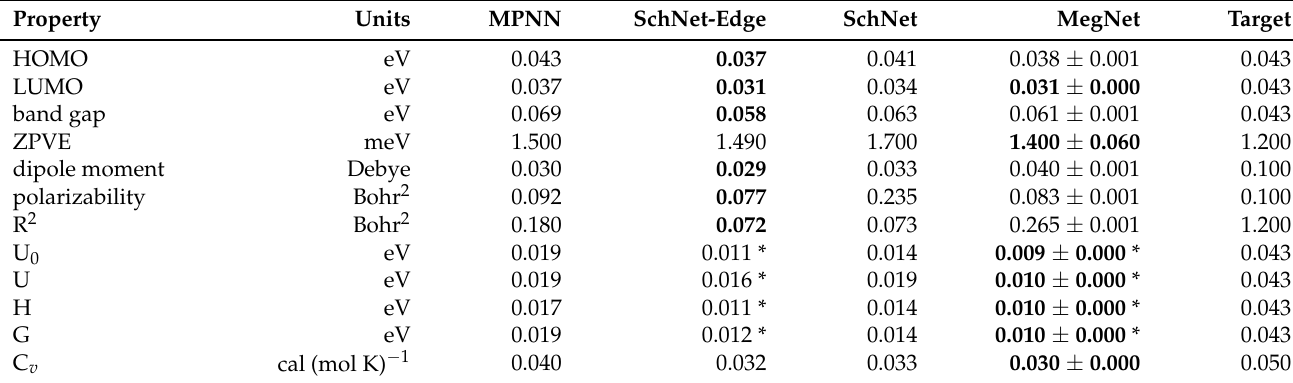
Table 2. Mean absolute errors obtained from several benchmark methods on 12 different properties using the QM9 molecular dataset. Bold represents the lowest mean absolute errors among the models. * represents the property trained for respective atomization energies. Target corresponds to the chemical accuracy for each property desired from the predictive ML